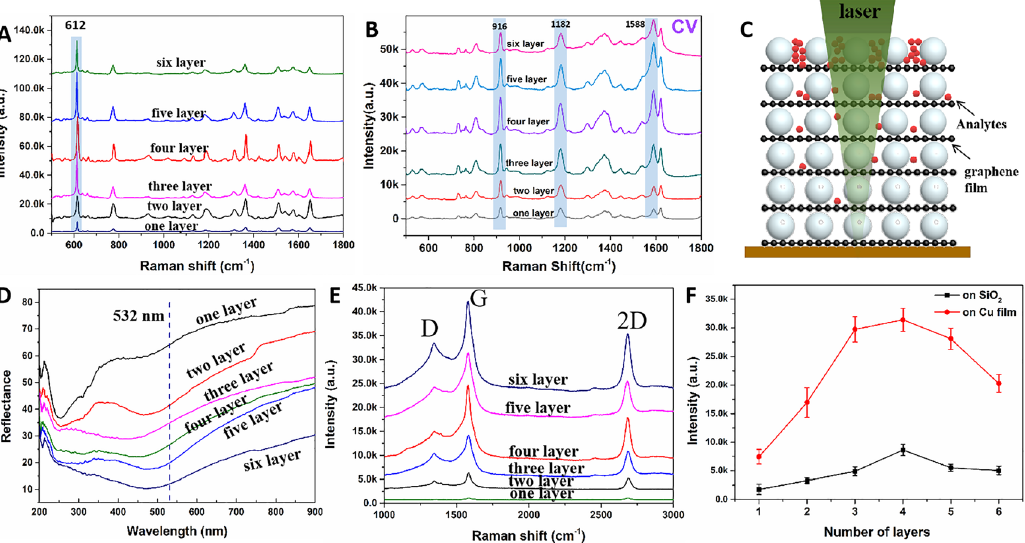
Figure 2: (A) The surface-enhanced Raman spectroscopy (SERS) spectra of R6G (10 − 6 M) collected from one- to six-layer substrates. (B) The SERS spectra of CV (10 − 6 M) collected from one- to six-layer substrates. (C) The schematic illustration of the analytes distribution using the dropping method. (D) The re fl ectance spectra of the MAgNP-CuF substrate. (E) The SERS spectra of graphene collected from MAgNP-CuF substrates with different layers, with graphene/Cu fi lm as contrast. (F) Comparison of SERS signals at 612 cm − 1 for the MAgNP with or without Cu fi lm. Each value was the mean of 20 random spots collected from each MAgNP-CuF substrates.